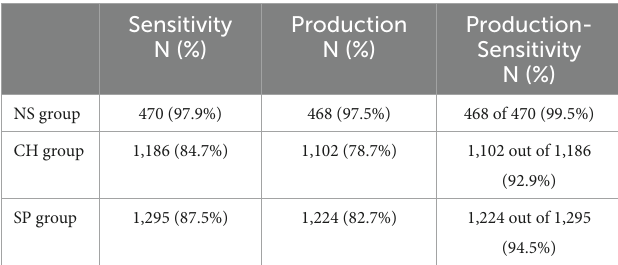
TABLE 1 Effective responses in grammatical sensitivity and production.